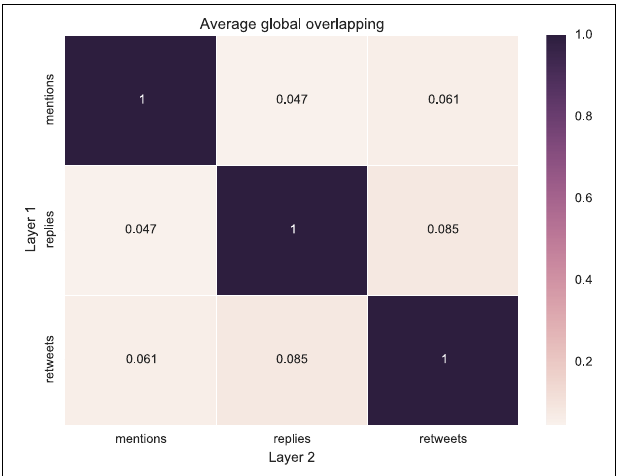
FIGURE 4 | Heatmap representing the average degree-degree correlation between layer